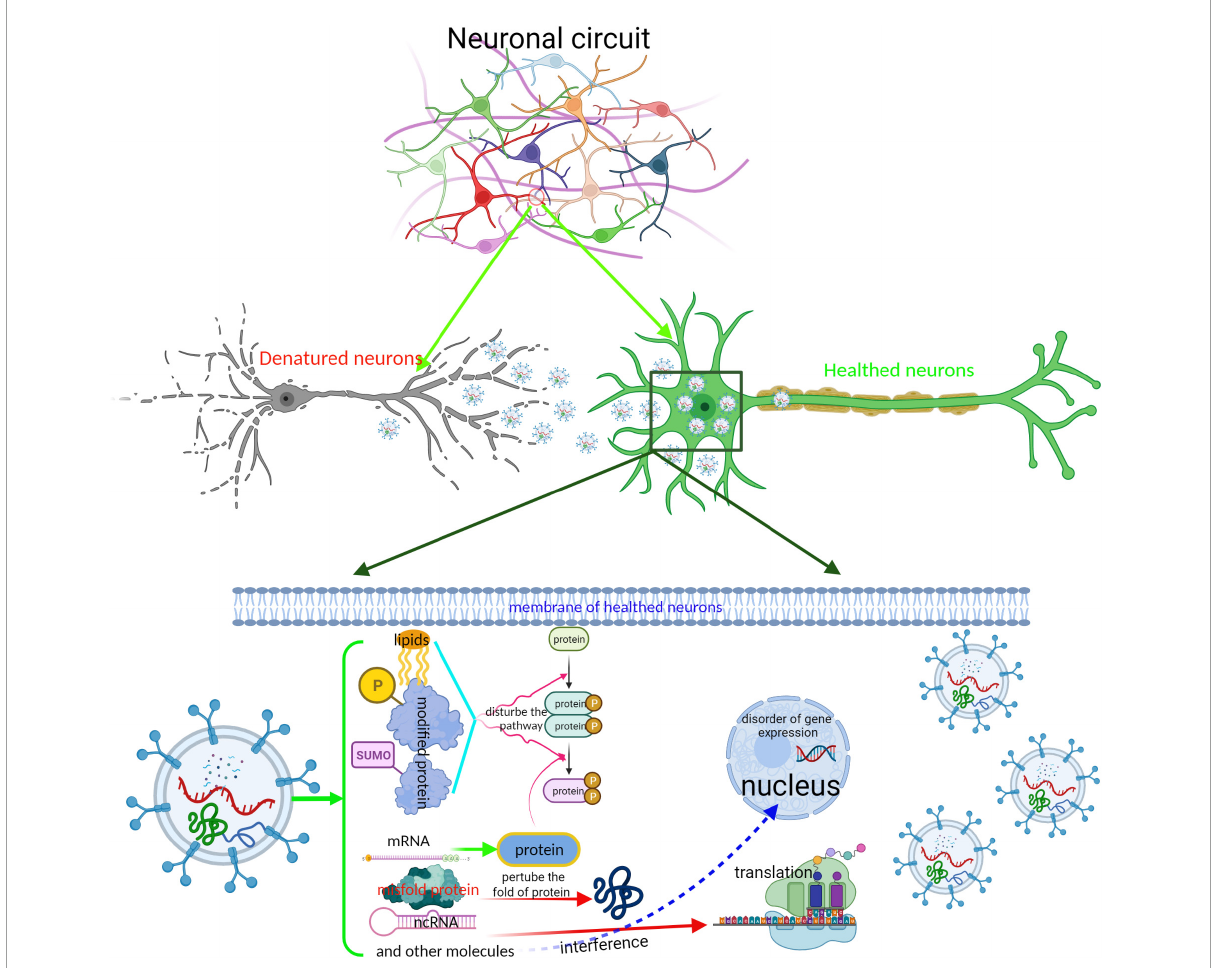
FIGURE3 Schematic representation of the interplay between neurons by EVs. EVs is an important tool for maintaining the completion of neuronal circuit and the delivery of neurotransmitters. EVs derived from impaired neurons containing abnormal regulators or neurotransmitters are absorbed into healthy neurons, perturbing the neuronal function. The completion of neuronal circuit depends on the neuronal function. Especially, those EVs containing misfold proteins, such as Tau, α -syn, and TDP43, spread to other neurons; these misfold proteins acting as “pathological seeds” induce misfolding of endogenous protein, cause a dissemination from local brain region to others, and accelerate disease